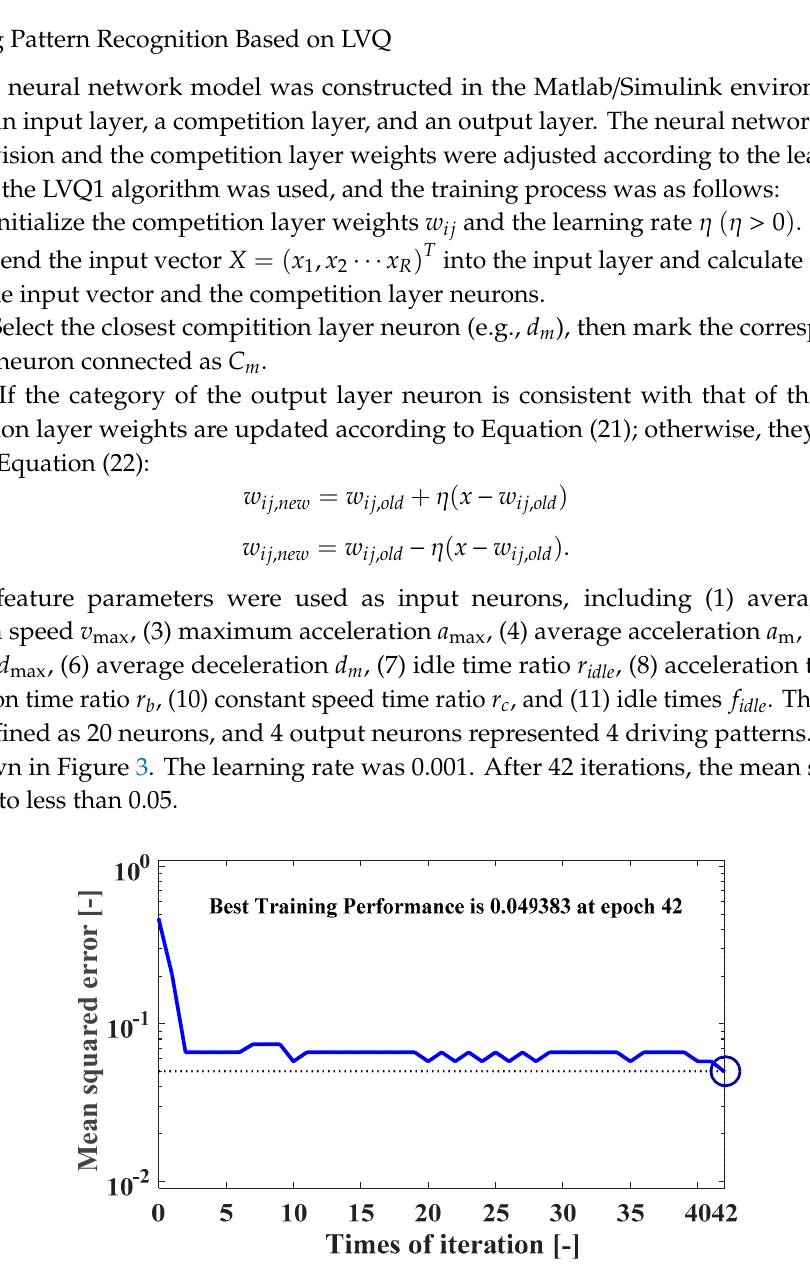
Figure 3. Training process of the learning vector quantization (LVQ) neural network.